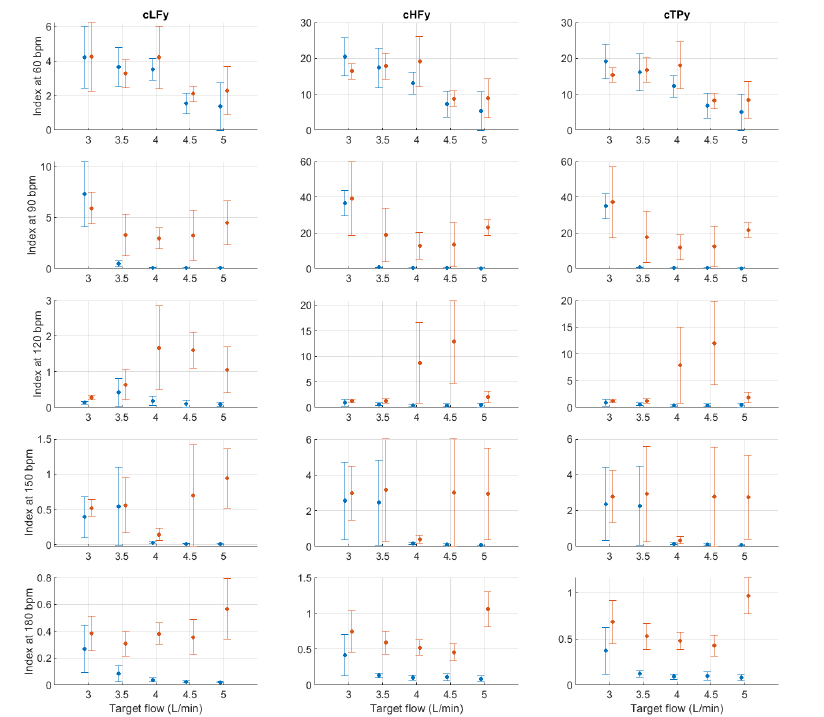
Figure A13. Mean and standard deviation of the y -coordinates of the centroid-related indices ex- tracted from pulse rate variability under different stroke rates (SR) and target flows (TF, TF above 2.5 L/min) conditions, and measured from the radial (blue) and deep palmar arch (orange) phantoms.